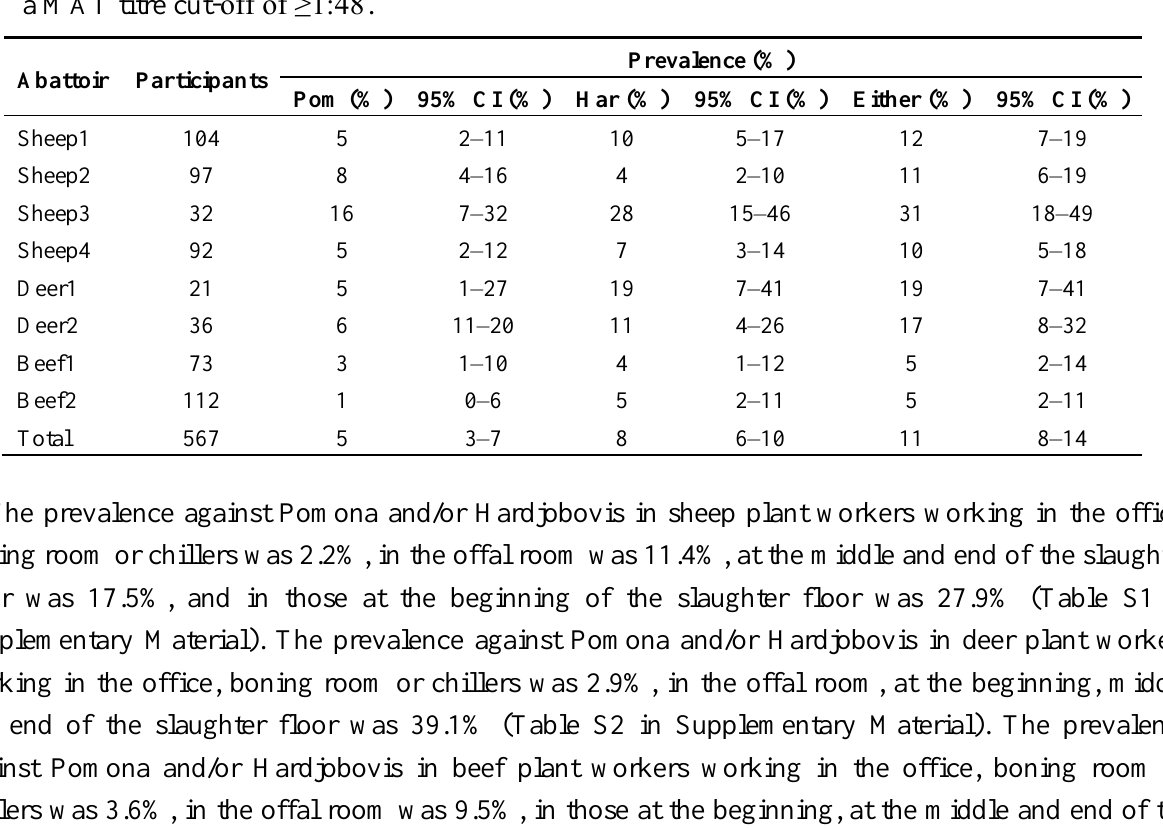
Table 3. Sero-prevalence (%) and 95% confidence intervals (CI) of workers of eight abattoirs processing sheep, deer or beef with antibodies to Leptospira interrogans sv . Pomona (Pom), Leptospira borgpetersenii sv. Hardjobovis (Har) and to either serovar with a MAT titre cut-off of